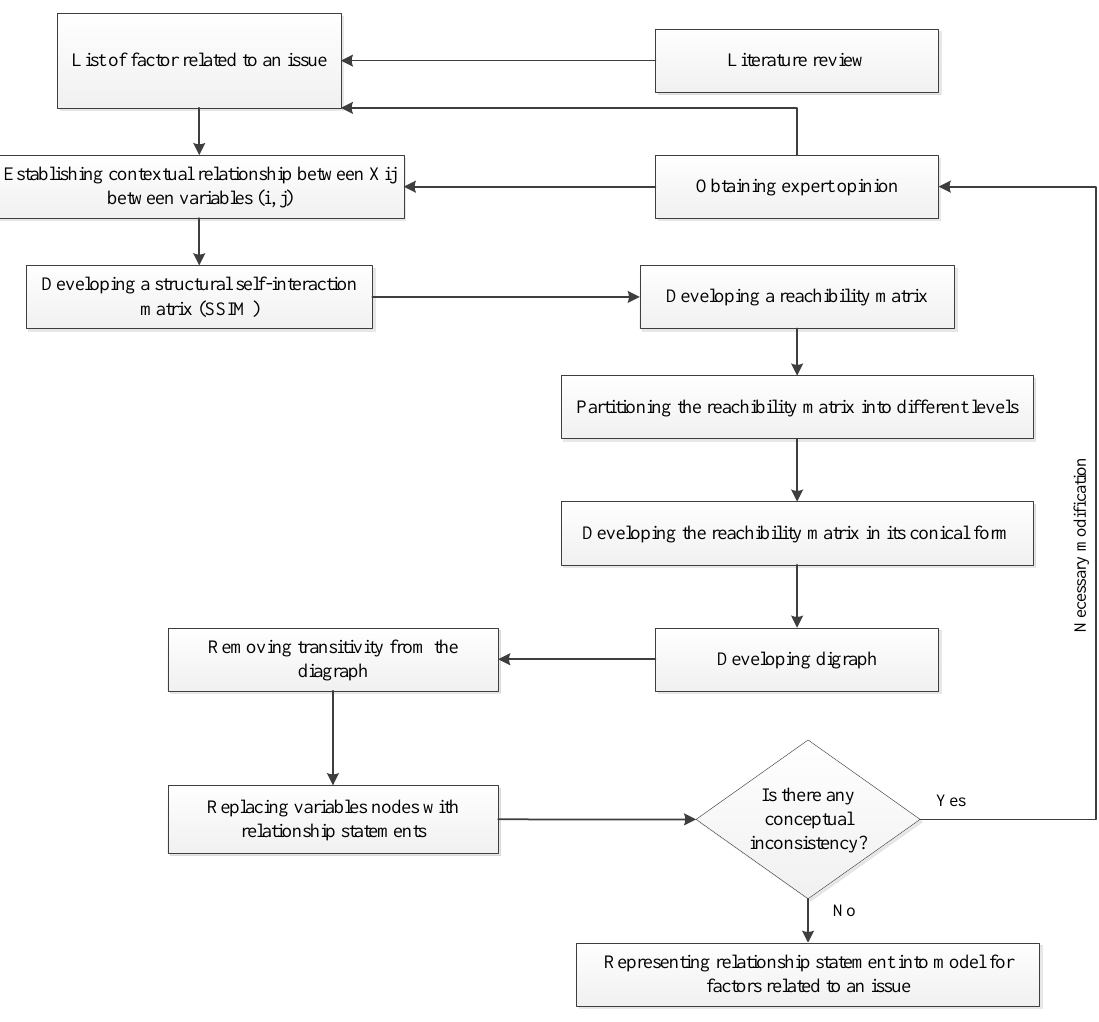
Fig. 3. Flow diagram for preparing ISM model (Kannan et al.,